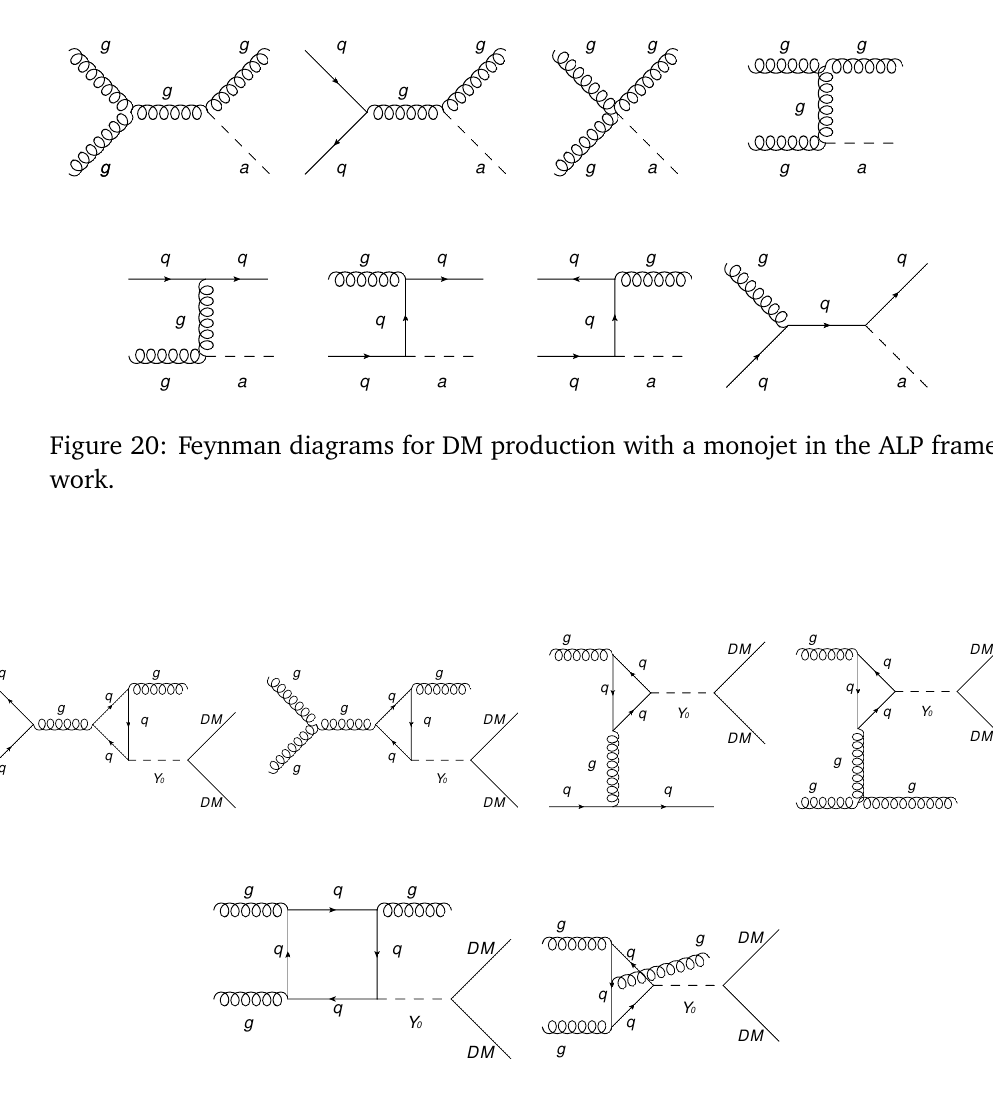
Figure 21: Feynman diagrams for DM production with a monojet in the spin-0 medi- ator framework. As mediator-SM quarks interactions are proportional to SM Yukawa couplings, loops are dominated by top-quark contributions.